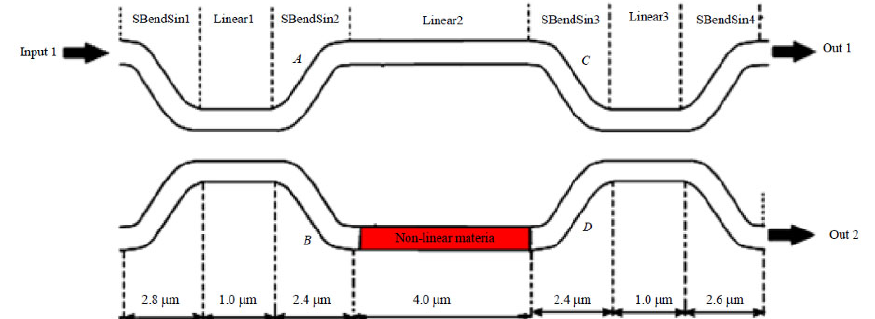
Fig. 1 Schematic of single Mach-Zehnder interferometer.